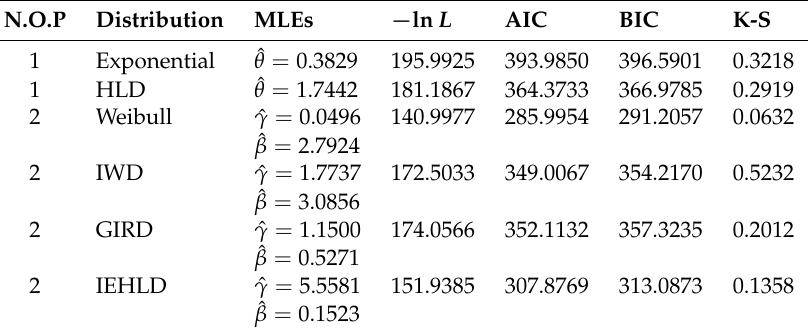
Table 22. Results of fitting different functions to the practical data.